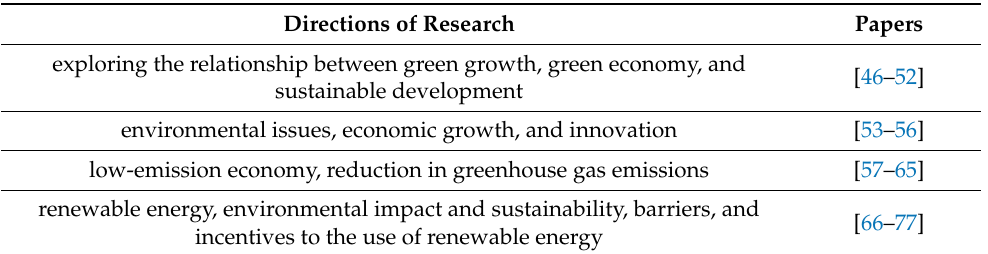
Table 1. Research directions in the field of green growth as a tool for sustainable development. Directions of Research